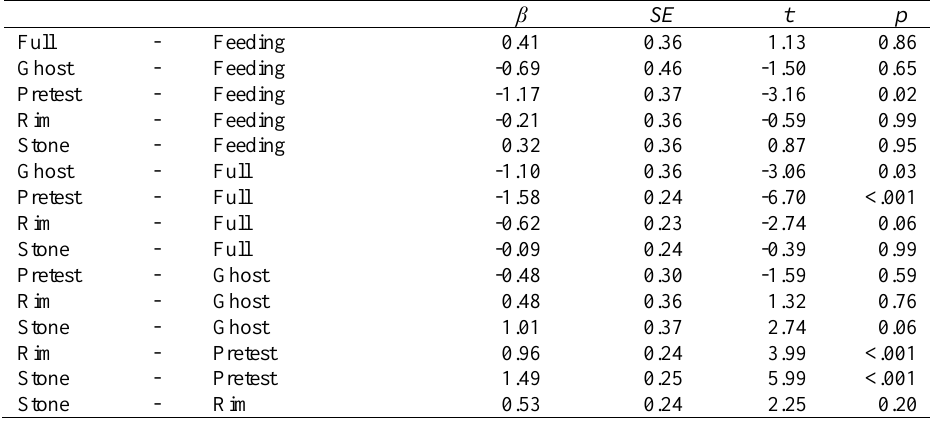
Multiple Comparisons of Time Spent Manipulating Stones (in Seconds) in Different Experimental Conditions β